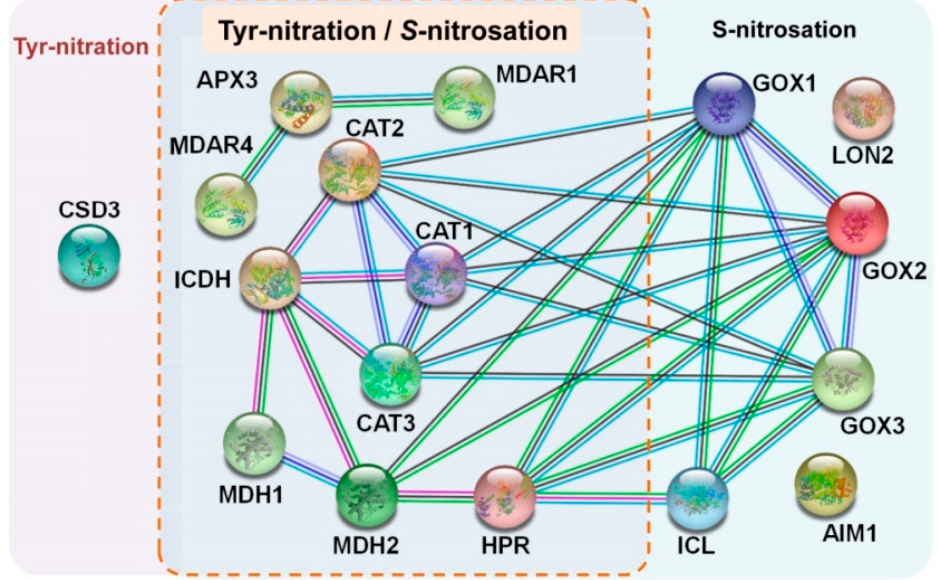
Figure 4. Predicted computational protein-protein interactions (PPIs) network of peroxisomal proteins undergoing NO-mediated post-translational modifications (either tyrosine nitration or S-nitrosation) in Arabidopsis. The color code for depicted lines is as follows: pink, experimental evidence; blue, database evidence; green, neighboring genes; dark-blue, gene co-occurrence; black, displays co-expression; purple, protein homology. The analysis was performed using STRING v11.0 with minimum required interaction score set in “medium confidence” (0.400). CAT, catalase. CSD3, CuZn-SOD. GOX, glycolate oxidase. HPR, hydroypyruvate reductase. ICDH, NADP-isocitrate dehydrogenase. ICL, isocitrate lyase. LON2, Lon protease homolog 2. MDAR, monodehydroascorbate reductase. MDH, malate dehydrogenase.